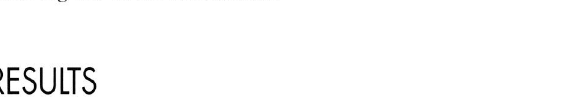
Table 1. - Prevalence of trichinellosis in vulpine populations from three regions of the